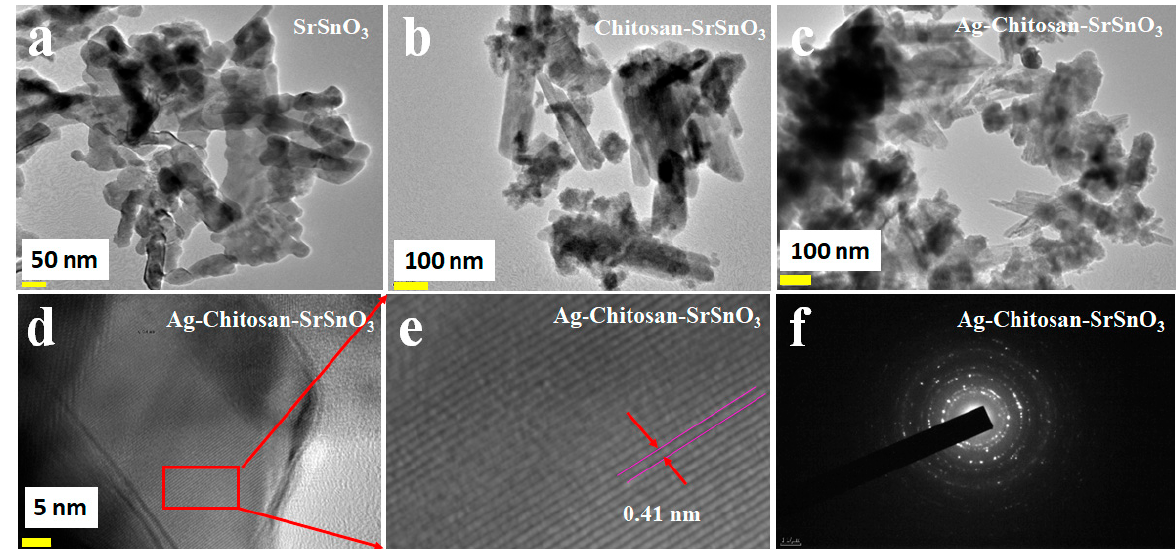
Figure 3. HRTEM analysis of Ag-decorated Chitosan/SrSnO 3 NC. ( a ) SrSnO 3 , ( b ) Chitosan/SrSnO 3 , ( c – e ) low-to-high magnified Ag-decorated Chitosan/SrSnO 3 NC, and ( f ) SAED pattern of NC.